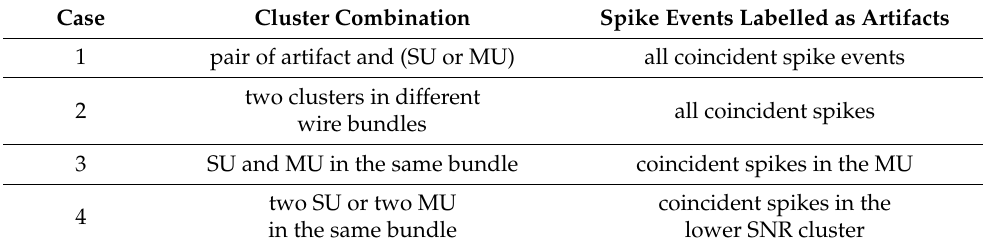
all coincident spikes coincident spikes in the lower SNR